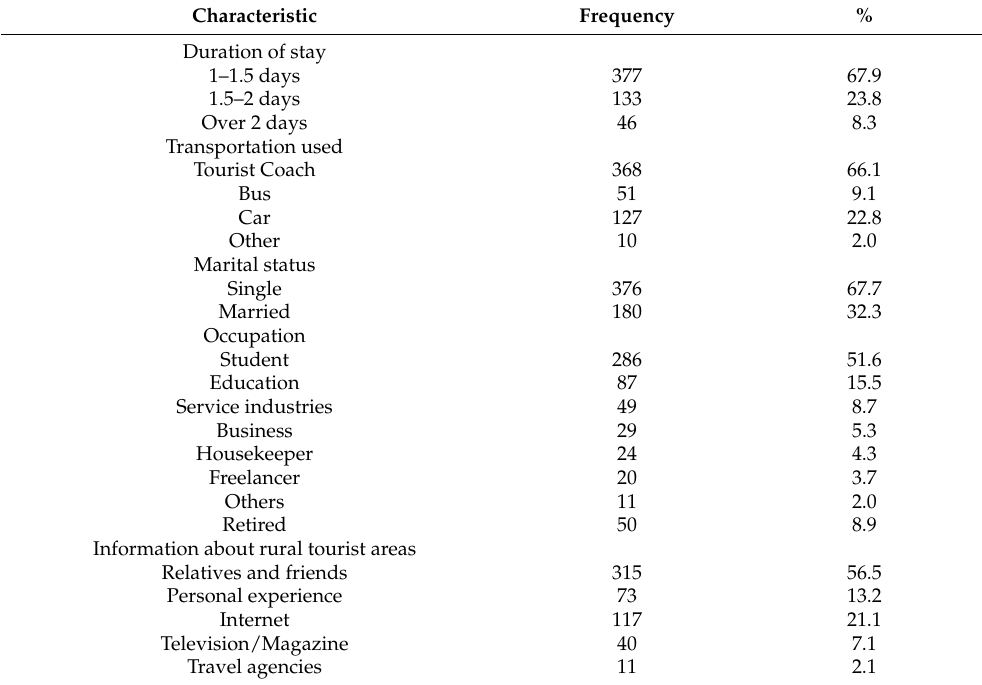
Table 1. Demographic and travel characteristic of respondents (N =